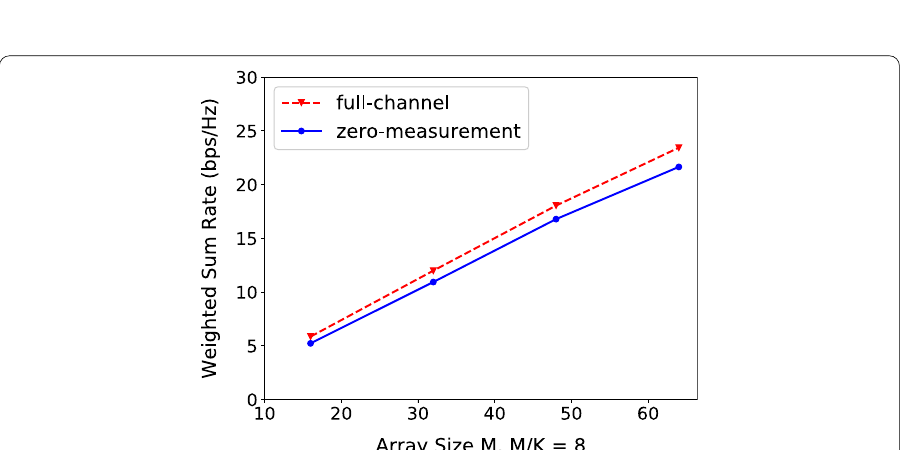
Fig. 8 The weighted sum rate with zero-measurement selection and full-channel selection, respectively. The system setup is that a changing number of antennas select changing number of users with fixed ratio as 8 out of 100 users for downlink beamforming based on measured